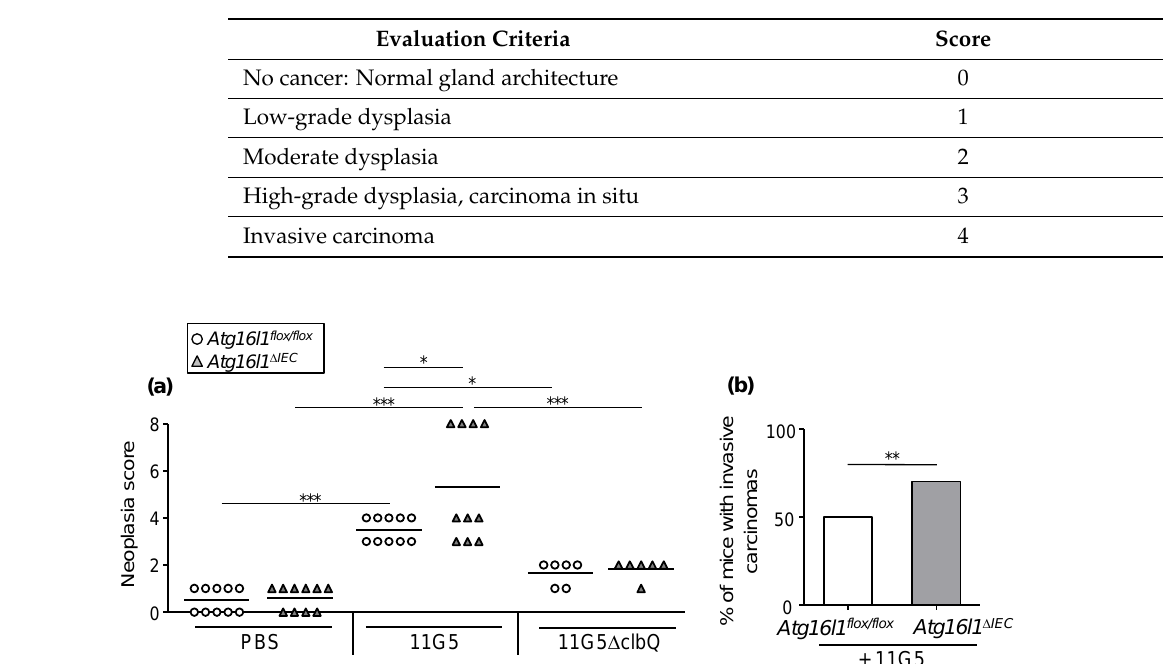
Table 1. Neoplasia score. To determine the neoplasia score, the criteria in the following table were examined for each mouse, giving a score. This score was then multiplied by “1” if 0–50% of the tumors of the mouse were invasive carcinomas and “2” if 50–100% of the tumors of the mouse were invasive carcinomas. The final value is the neoplasia score.